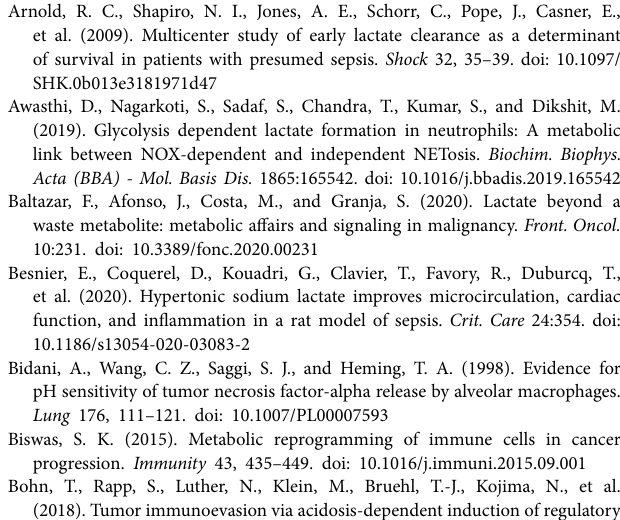
Supplementary Table 1 | Detailed findings reported in lactate-immune literature. Effect on inflammation noted by color: blue = decreases, orange = increases, green = both. Cell type abbreviations: PBMC, peripheral blood mononuclear cell; (i) BMDM, (immortalized) bone marrow-derived macrophage; MDDC, monocyte-derived dendritic cell; MDM, monocyte-derived macrophage; MDSC, monocyte-derived suppressor cells; BMMC, bone marrow-derived mast cells; BMDM, bone